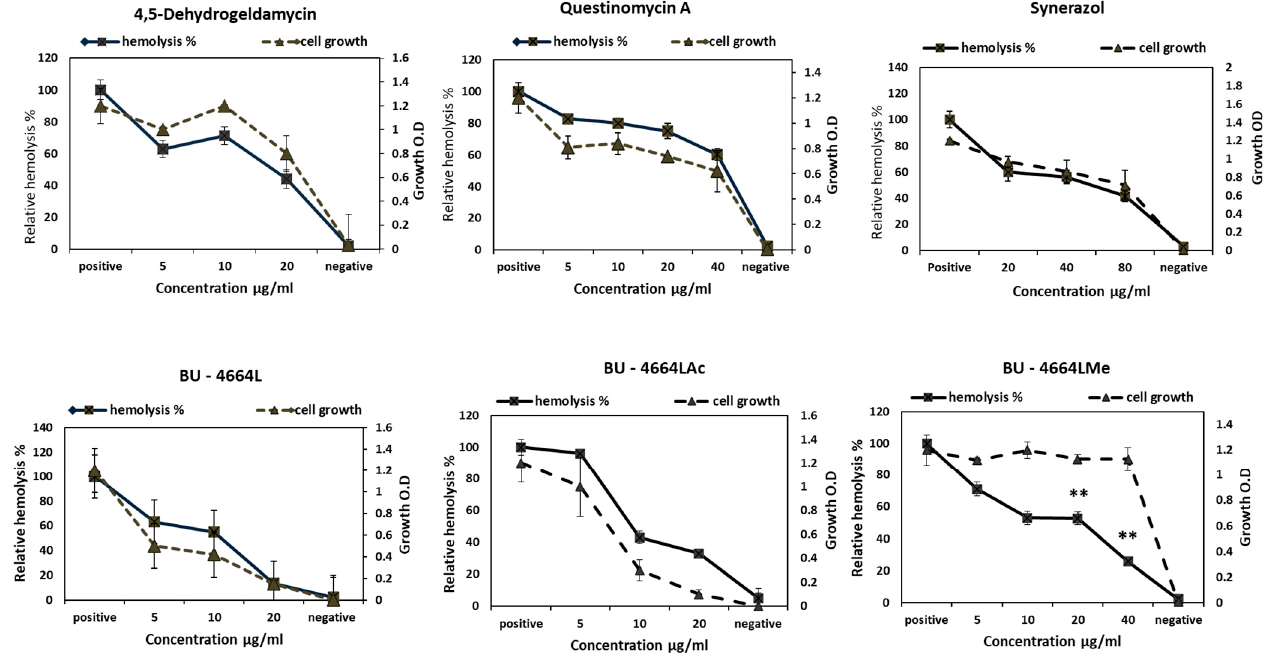
Figure 6. Anti-hemolytic activity of 4,5-dehydrogeldnamycin, Questiomycin A, Synerazol, BU–4664L, BU–4664LMe, and BU–4664LAc on S. aureus ATCC 29213. Significant differences are indicated by ** p < 0.05.